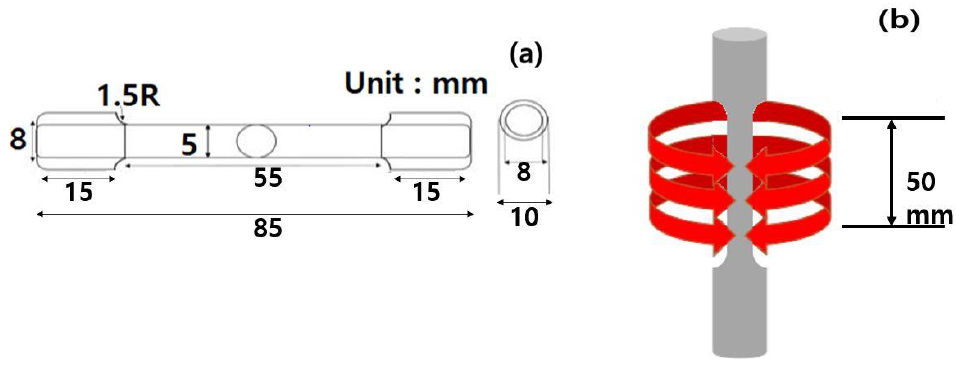
Figure 1. Tensile specimen with a diameter of 5 mm ( a ) placed in a vacuum chamber with an induction coil of 50 mm length for heating the tensile specimen ( b ).